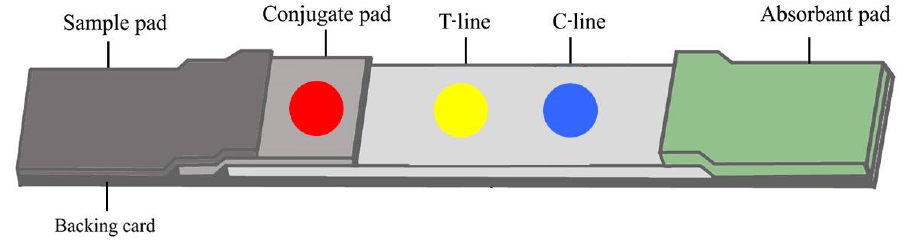
Figure 1. Schematic view of colloidal gold test strip for antibody detection. The strip was an assembly on polystyrene backing card. The strip consists of a sample pad, conjugate pad, nitrocellulose membrane, and absorbent pad. The conjugate pad was immobilized with rFgCathL1H-conjugated colloidal gold ( red dot ). The nitrocellulose membrane strip consists of rFgCathL1H ( yellow dot ) and rabbit anti-rFgCathL1H ( blue dot ), which were immobilized as a T-line and a C-line, respectively.